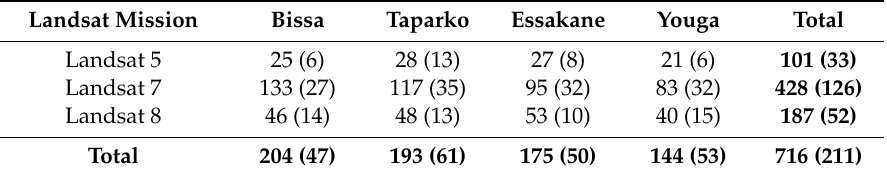
Table 1. Available Landsat images with < 10% cloud cover by study area and Landsat mission. Numbers in parentheses indicate the number of retained images after the visual quality assessment of the initial land use